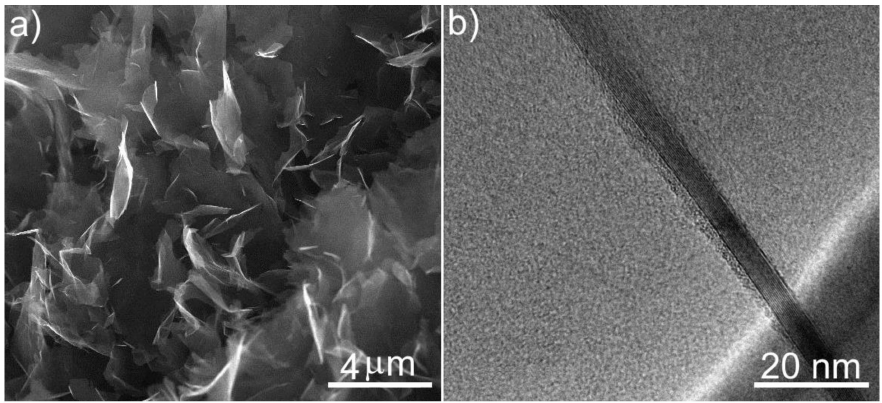
Figure 2. ( a ) SEM and ( b ) TEM micrographs of GNP microstructure.